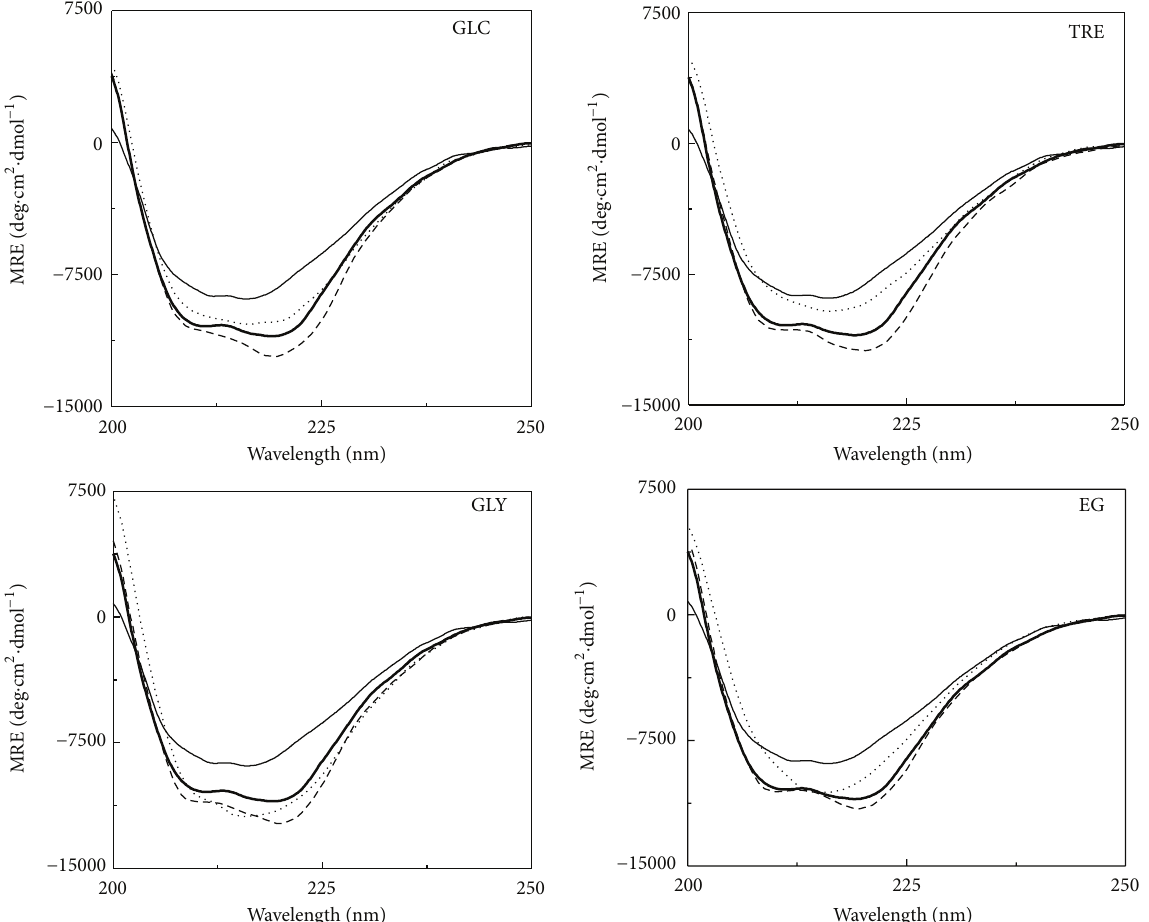
Figure 1: Effect of various polyols, such as, glucose (GLC), trehalose (TRE), glycerol (GLY), and ethylene glycol (EG), on the far-UV CD spectra of the native and the acid-denatured GAs. Different line symbols represent native GA (thick curve), acid-denatured GA (thin curve), native GA + polyol (dashed curve), and acid-denatured GA + polyol (dotted curve). The spectra were recorded at 25 ∘ C using a protein concentration of 1.4 𝜇 M. Different polyol concentrations used were 2.6M GLC, 1.3M TRE, 8.0M GLY, and 8.0M EG. Table 2: Effect of various polyols on the fluorescence spectral characteristics of different states of GA. Polyols